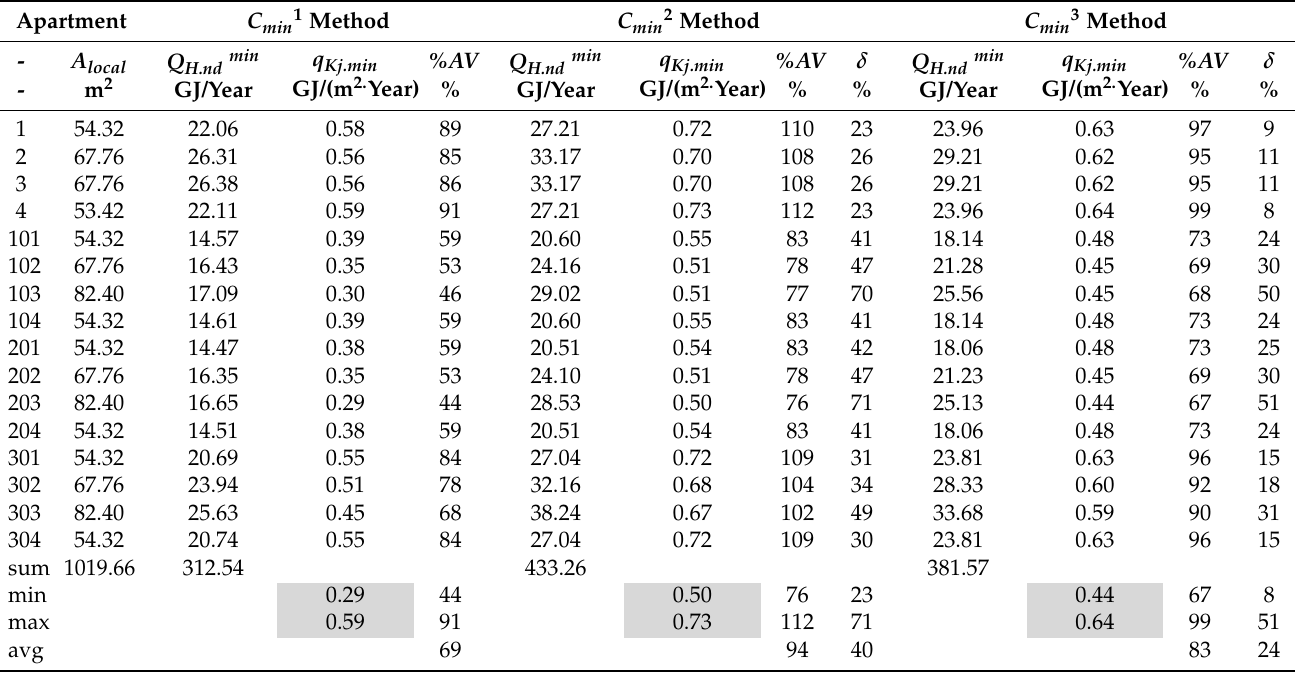
Table A2. The results of the unit minimum final energy consumption in the individual apartments of the analyzed building before